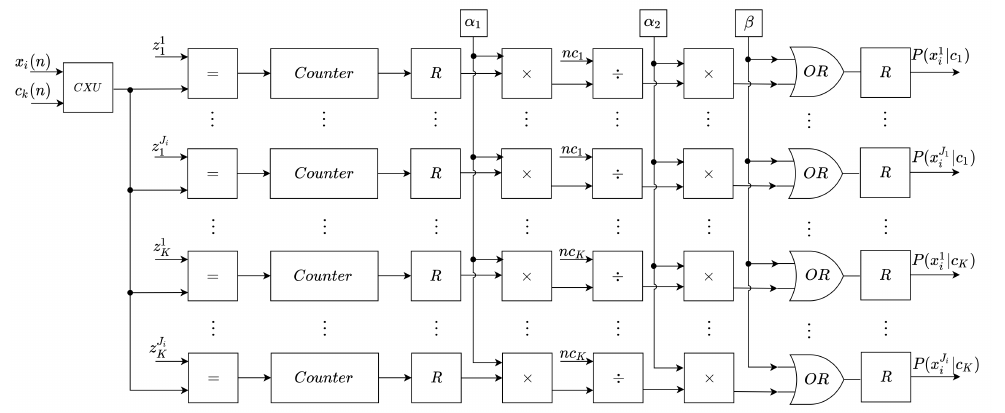
Figure 5. Internal architecture of an i -th APM.